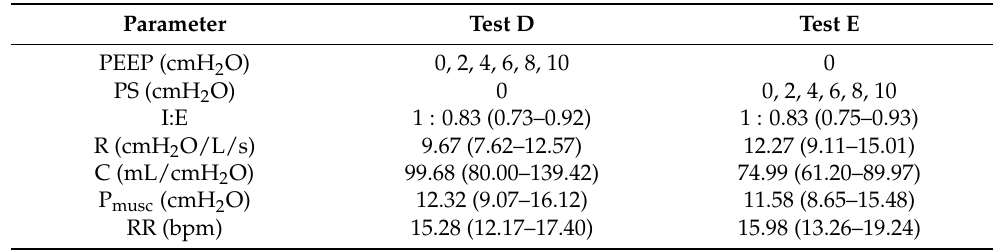
Table 2. The median and interquartile range of the MV parameters and ventilatory mechanics of the subjects in Test D and E in DB